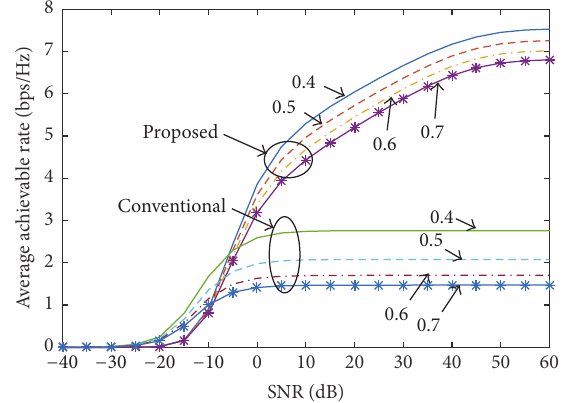
Figure 4: Average achievable rate comparison versus different 𝛽 𝑐 ( 𝑇 = 15, 𝐷 = 3 , and 𝐾 = 3